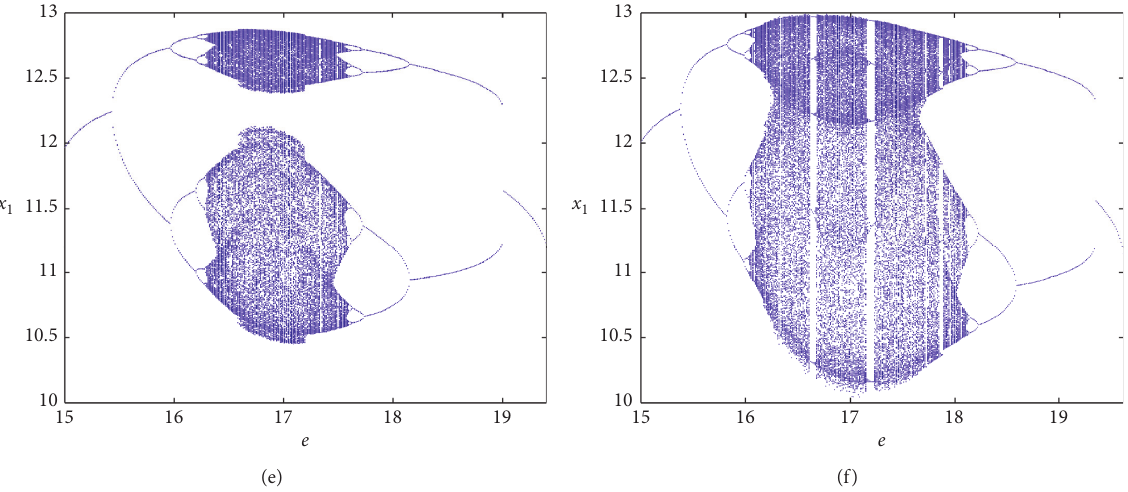
of the attractor in Poincar´e cross section in terms of the control 1